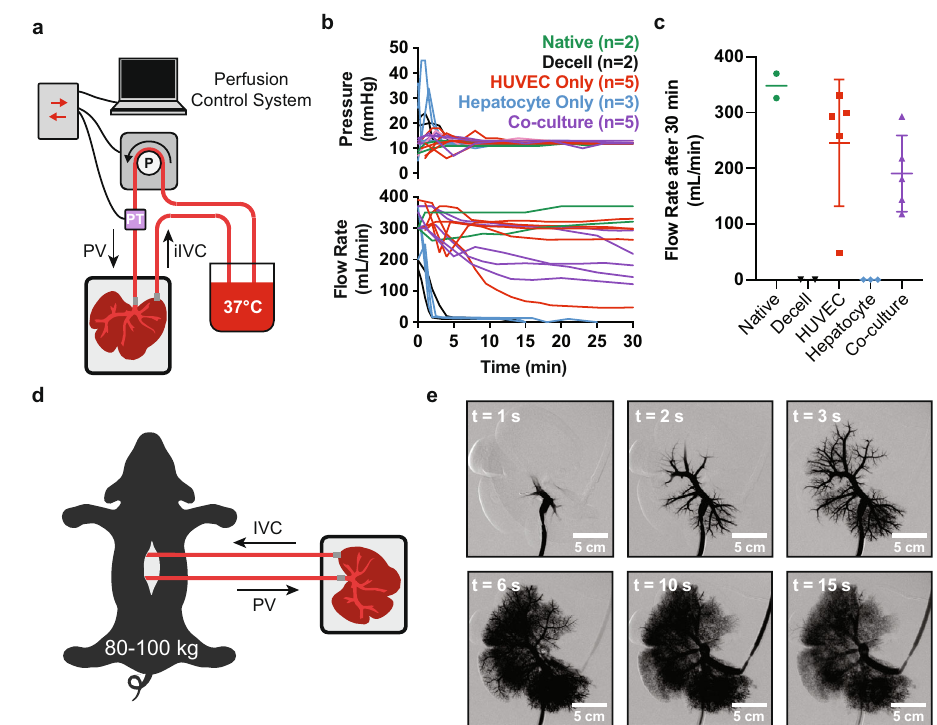
Fig. 3 Acute blood perfusion studies to assess vascular patency in BELs. a Schematic of in vitro blood perfusion circuit. 37 °C porcine blood is perfused at 12 mmHg through the PV with a peristaltic pump and returned to a reservoir through the IVC. b Summary plots of pressures and fl ow rates measured over 60 minutes during in vitro blood perfusion studies using HUVEC only, hepatocyte only, or co-culture BELs. Freshly explanted (Native) porcine livers and decellularized scaffolds (Decell) were included as benchmarks for idealized perfusion and rapid thrombosis, respectively. c Violin plots summarizing BEL fl ow rates from ( b ) after 30 min of perfusion. d Schematic of ex vivo blood perfusion model. A synthetic perfusion circuit is established by cannulating the PV and sIVC within an anesthetized pig. Blood fl ow is diverted from the animal ’ s cannulated PV to the BEL PV and returned from the BEL sIVC into the animal ’ s cannulated iIVC. e Real-time angiography time lapse imaging following contrast infusion. Imaging was performed after 30 min of continuous blood perfusion. PV — portal vein; BEL — bioengineered liver; sIVC — suprahepatic inferior vena cava, iIVC — infrahepatic inferior vena